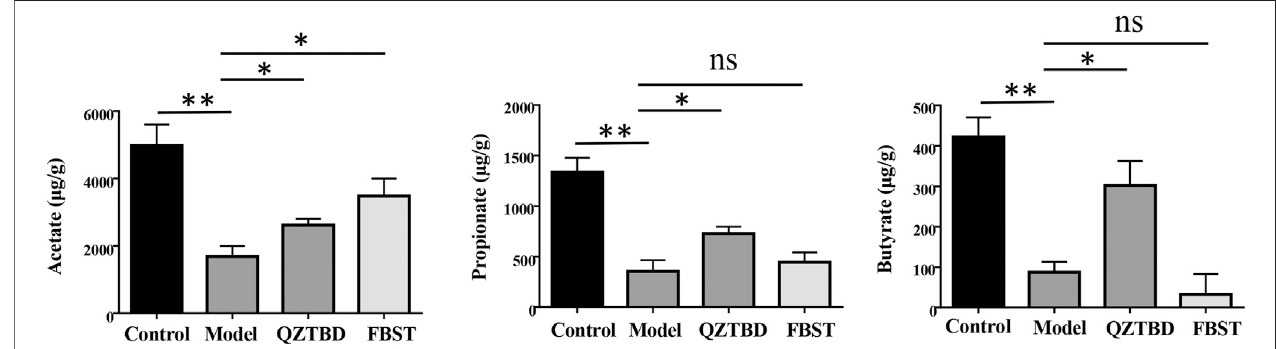
FIGURE5| QZTBD in fl uencesthefecalSCFAslevels. Acetate (A) ,Propionate (B) and Butyrate (C) . “ ns ” represents notsigni fi cant; “ * ” represents p < 0.05and “ ** ” represents p < 0.01. N (cid:2)